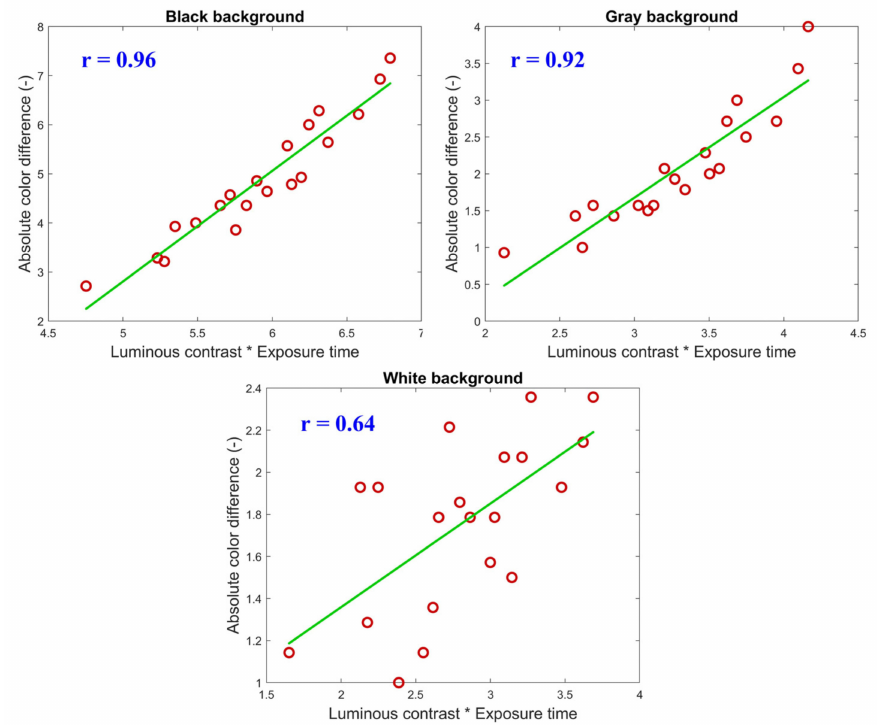
Figure 10. Relationship between absolute color difference and luminance contrast with exposure time (Stimulus/Background).